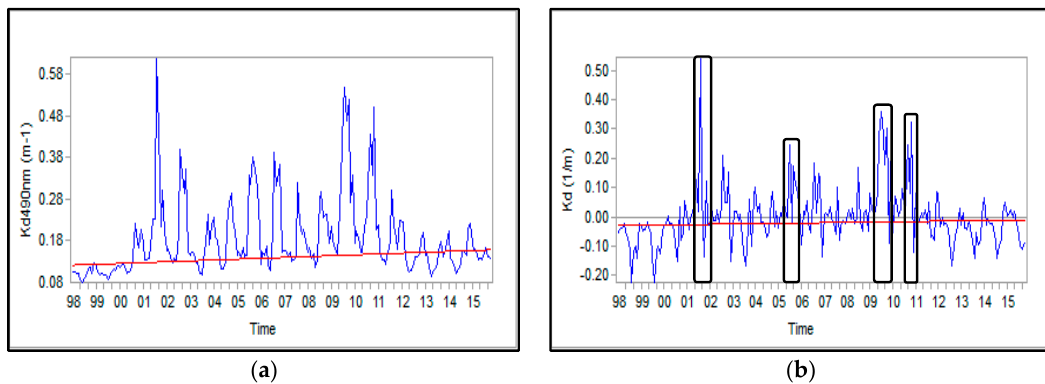
Figure 6. Time series of attenuation coefficient in the SCS; ( a ) absolute values and ( b ) anomalies. Absolute values and anomalies of Rrs_555nm in the SCS are shown in Figure 7. Rrs_555nm decreased in the time series; that is, the suspended matter during the analyzed period reduced, so that the values of the peaks in later phases were smaller than those in the beginning ones. The years of 2001, 2009, 2012, and 2015 exhibited higher values than other years. ( a ) ( b ) Figure 7. Time series of Rrs_555nm in the (SCS): absolute values ( a ) and anomalies ( b ). 3.2.1. Median Trend Analysis of Bio-Optical Parameters Figure 8 shows the mean values for median trend analysis of Chl-a. Apart from blocks 3 and 15a, other blocks indicate an upward trend; the highest variation rate was observed in 4B, 4c and 8d (0.002), 8, 8b and 8c, 15b, and 25 (0.001). Overall, the annual variation rate for the Chl-a in the SCS displayed an upward trend (0.018 mg m − 3 year − 1 during 1998-2015) while the variation rate for the entire time series was 0.3358 mg m − 3 (Figure 11a). During the 1998-2015 time period, the highest downward rate of changes was observed in the block 4a (7 mg.m − 3 ) in the eastern part and block 3C (5.61 mg m − 3 ) and 4 (4.44 mg.m − 3 ) in the western part. A possible explanation for this might be the anti- and cyclonic gyres, which occur in the south and middle of the SCS, respectively. The attenuation coefficient increased and decreased in the SCS (Figure 8b). The rate of changes in southern (24, 25 and 26) and south-eastern (14 and 15) blocks and in blocks of 3C, 4C, and 4a were relatively higher than the other blocks, with an average of 0.011 (1/m). In regards to the attenuation coefficient, it displayed an increase by a factor of 2.34. Furthermore, the middle trend analysis of Rrs_555nm revealed that RSR underwent smaller variation rates in central blocks than in the eastern blocks. In eastern parts, the maximum variation rate of RSR was related to block 15a, with being a negative value (Figure 8c).